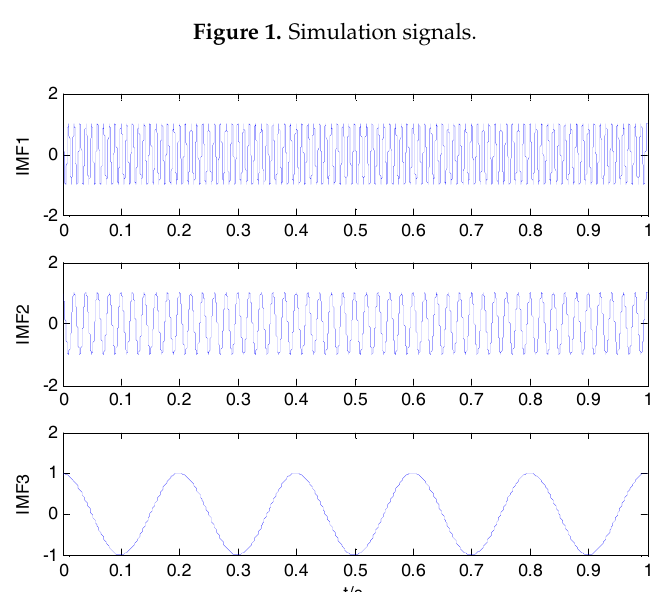
Figure 1. Simulation signals.